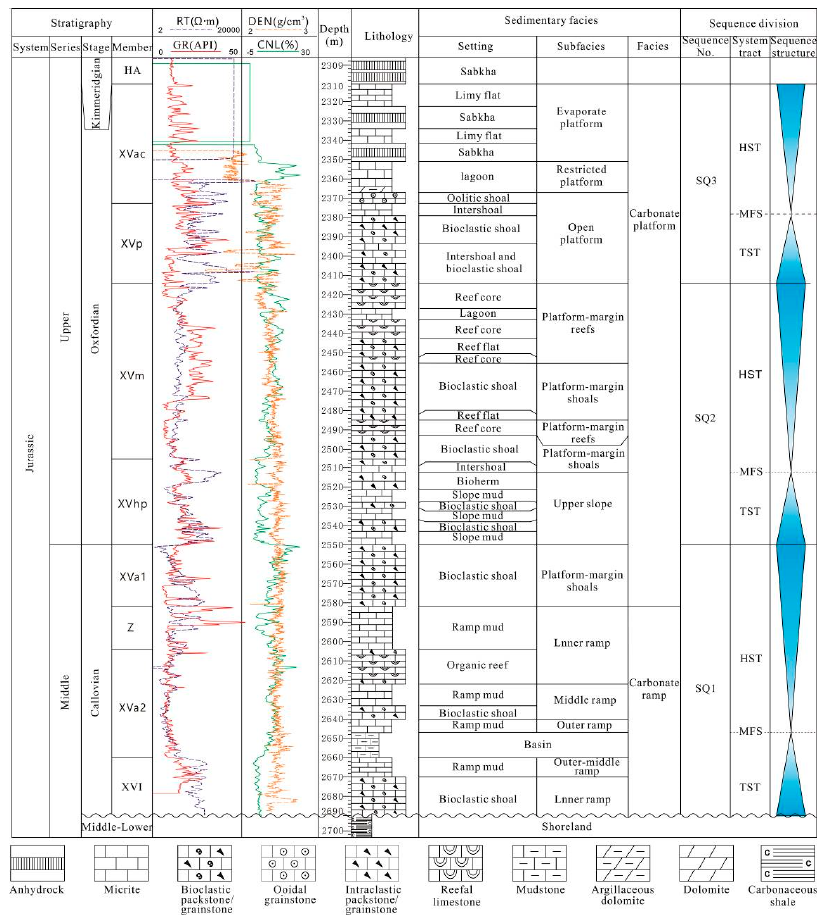
Figure 4. Lithological, chronostratigraphy and stratigraphic sequence of Callovian-Oxfordian Stage in Amu Darya